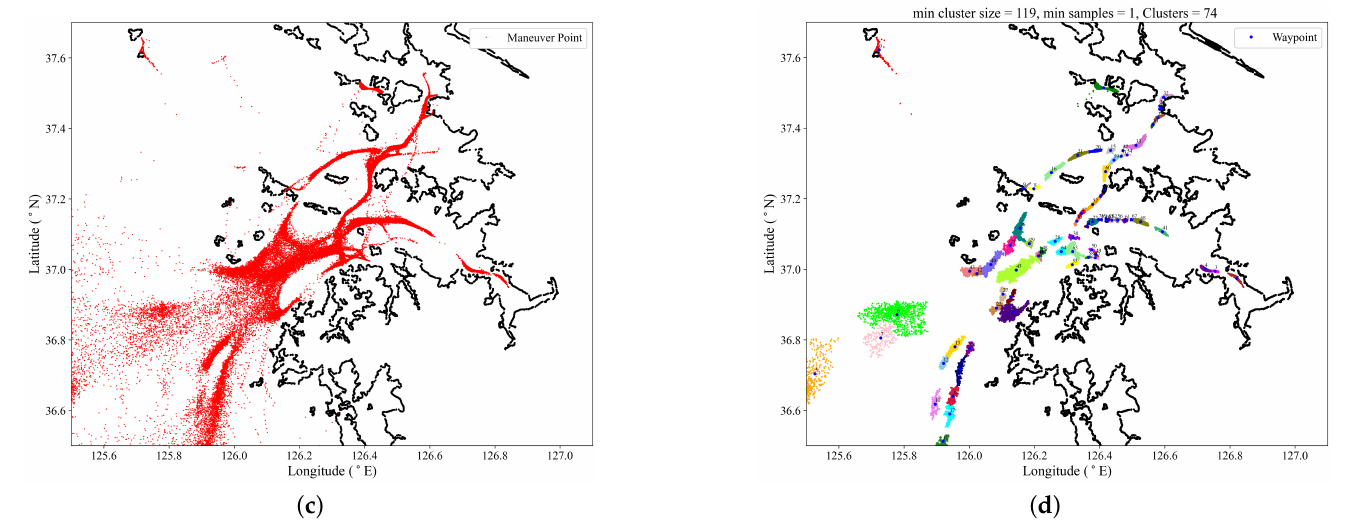
Figure 7. HDBSCAN clusters extracted after selection of optimal min cluster size . ( a ) Clustering performance metrics of HDBSCAN. ( b ) Elbow method; correlation between the number of clus- ters and cluster size. ( c ) Maneuver points scatter plot when ζ = 0.05. ( d ) HDBSCAN clusters and